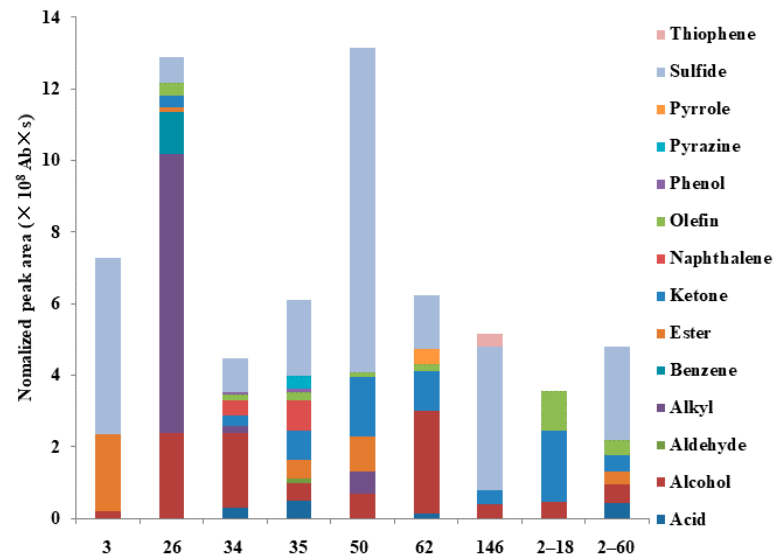
Figure 3. Types and normalized peak area of VOCs emitted from different bacteria.